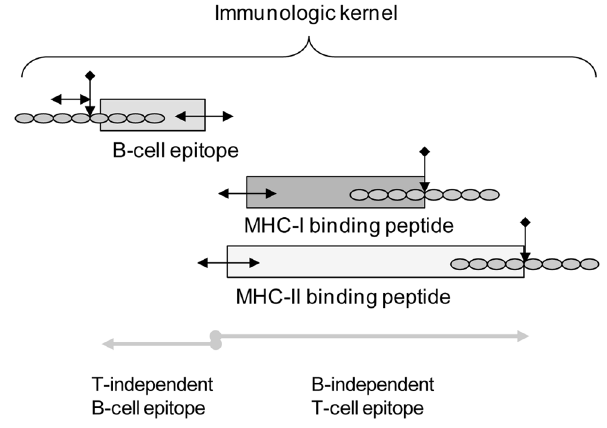
Figure 7. Conceptual model of an immunologic kernel. Relationships of the components are shown based on the cross correlations conducted. Two-headed arrows indicate there will be minor positional differences based on the host MHC alleles. Cathepsin cleavage is a requirement at the C-terminal of the MHC peptides; a high frequency of cathepsin cleavage occurs on the proximal side of the B- cell epitope, but no functional requirement for such cleavage has been demonstrated. Each cleavage site comprises an octomer, with the central P1-P1’ scissile bond indicated by the vertical arrow and the octomer amino acids shown as beads. We have characterized a kernel to comprise both B-cell epitope and T-cell epitope components; as shown T-independent and B-independent epitopes comprise subunits of the whole.